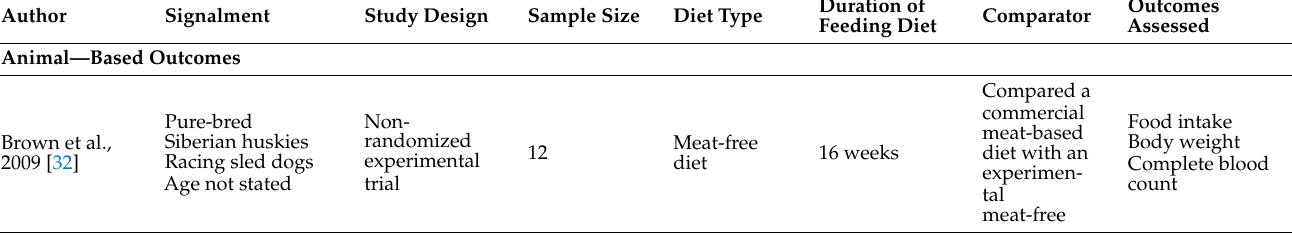
Table 2. Characteristics of studies evaluating vegan diets in